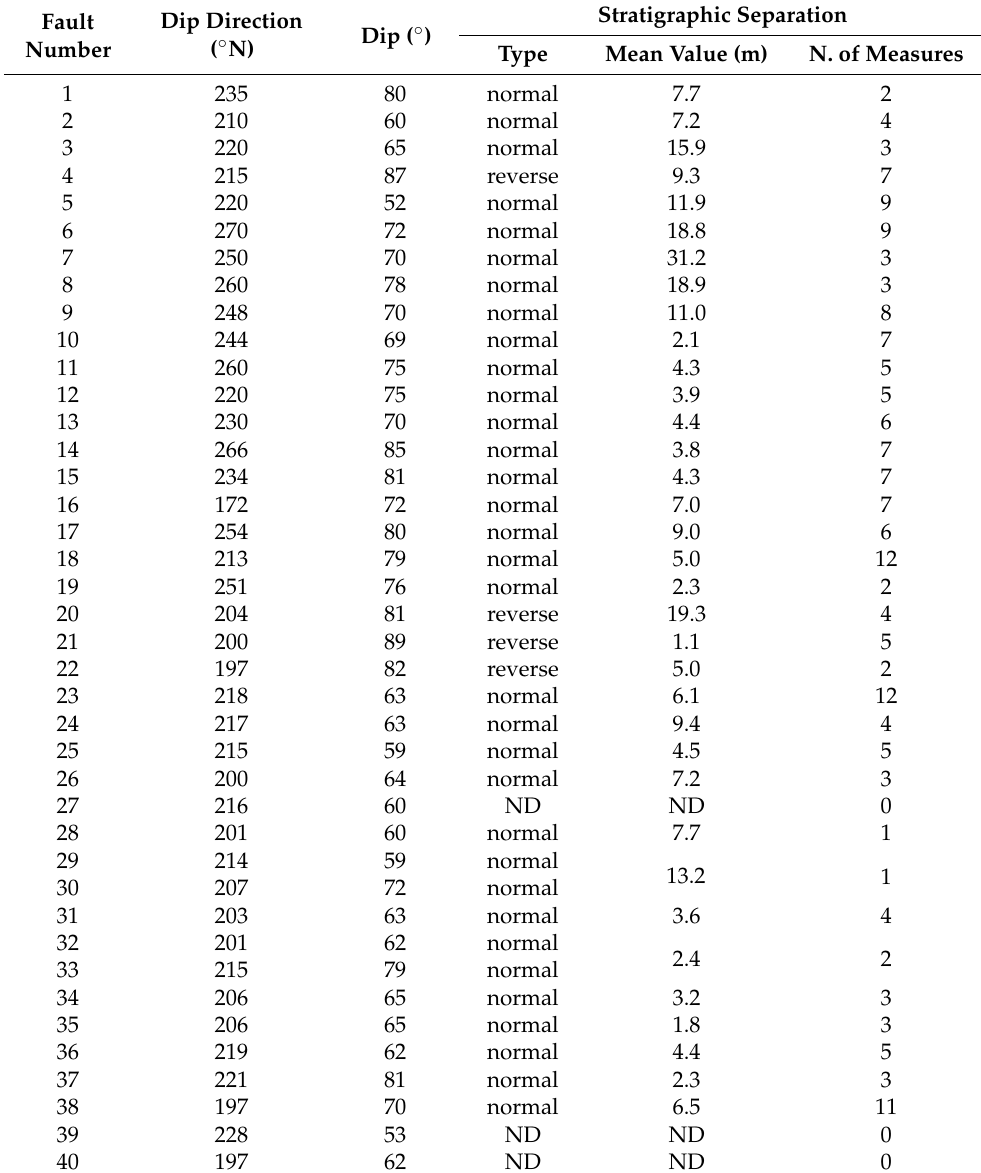
Table 2. Fault orientation and stratigraphic